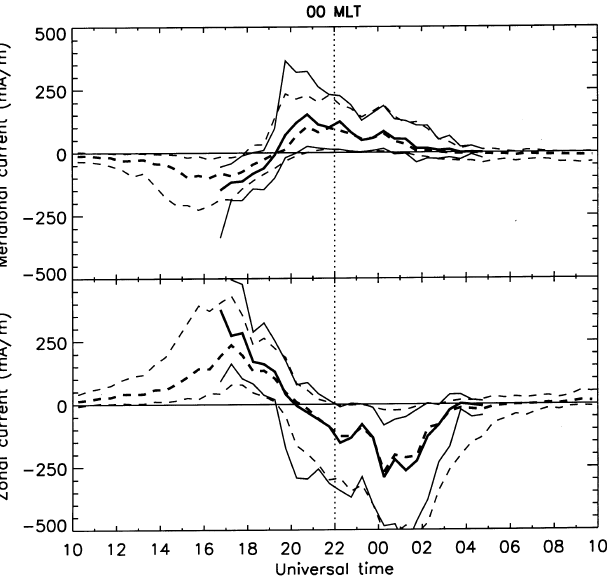
Fig. 3. UT variation of the field-perpendicular north-south current density ( upper panel ; positive northwards) and the field-perpendicular east-west current density ( middle panel ; positive eastwards). The format is identical to that of Fig.